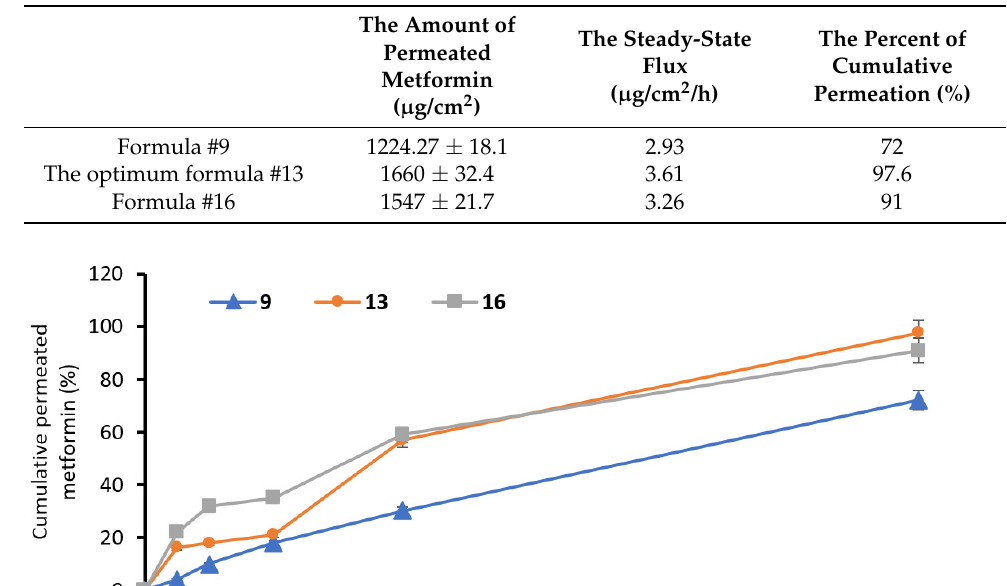
Table 2. Skin permeation parameters after 24 h.